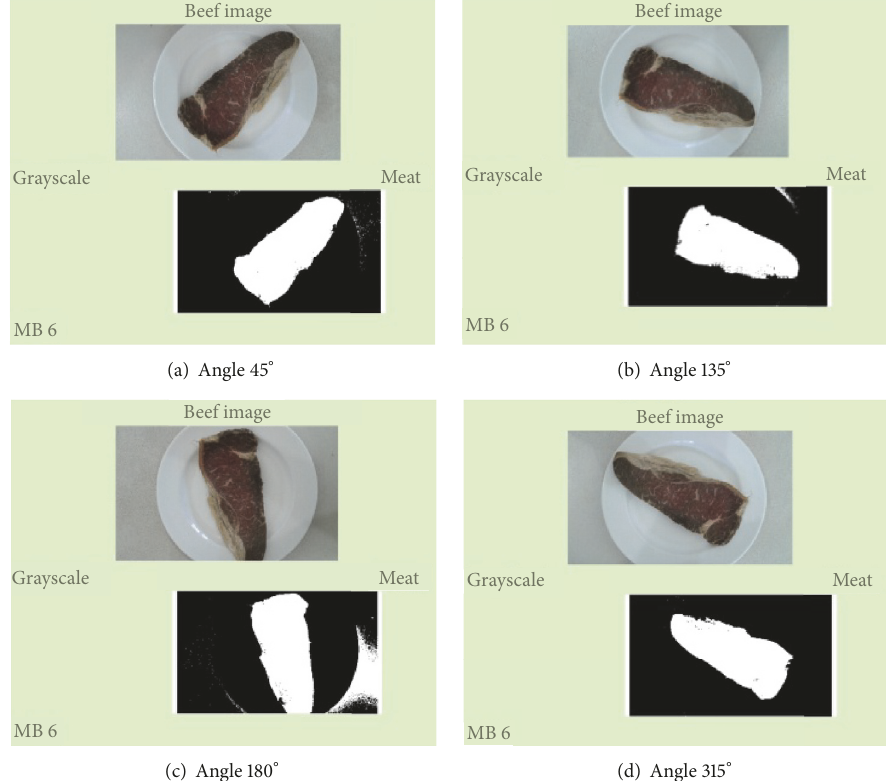
Figure 8: Example of testing result for variation of angle with marbling score (MB) 6.